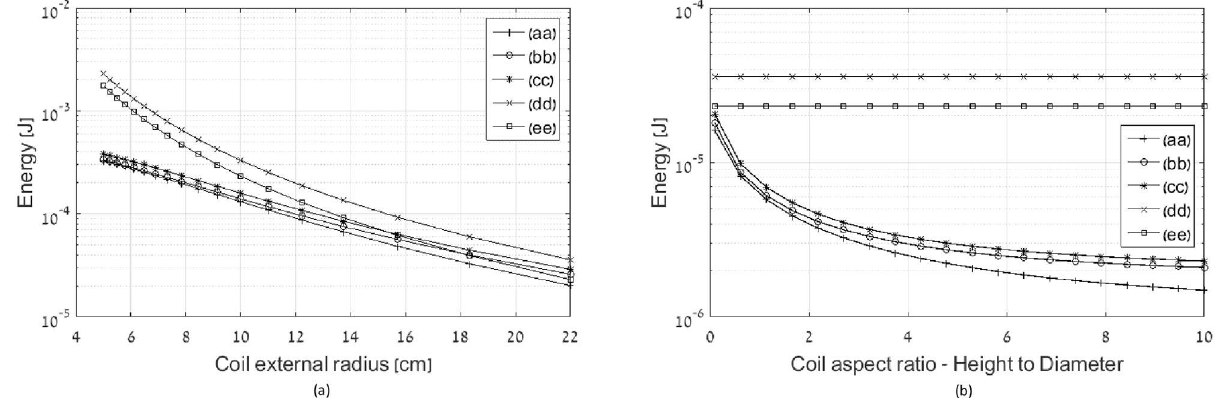
Fig 6. (a) Energy stored at various coil topologies with constraint of constant volume and weight, (b) energy stored at various coil topologies as function of aspect ratio with constraint of constant number of turns. The energystored in flat coils having the same radius are shown for reference only. Legendentries: (aa) Optimal current distributionmulti-layer solenoidcoil, (bb) Optimal current distributionsingle layer solenoidcoil, (cc) Constant current singlelayer solenoidcoil, (dd) Constant current single layer flat coil, and (ee) Optimal current distribution spiral flat coil.